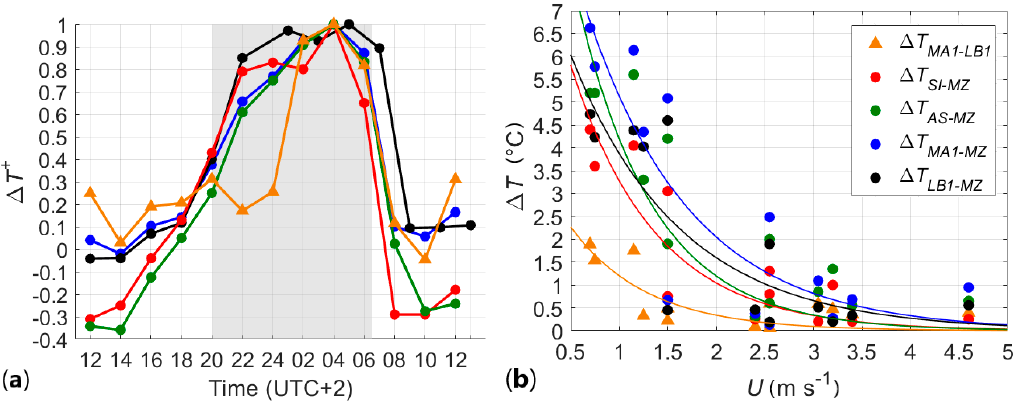
Figure 6. ( a ) Normalized UHI intensity (solid lines) evolution within the day of the summer intensive thermographic campaign in Bologna (22–23 August 2017). The shadowed region defines the nocturnal period between sunset (2000 UTC) and sunrise (0630 UTC). ( b ) UHI intensity as a function of the wind speed. Different locations are compared. City scale UHI is shown with full circles, neighborhood scale UHI with full triangles.